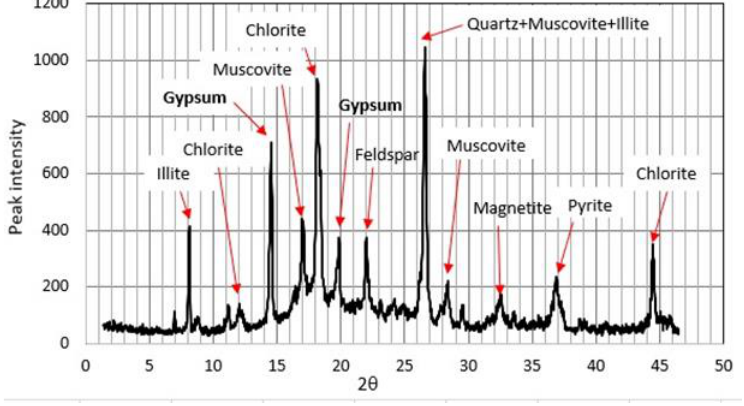
Figure 5. Mineralogy of the silty layer identified by X-ray diffraction. θ: Bragg angle ( °). The two marked peaks of hemihydrate gypsum exist as a mineralogical feature.